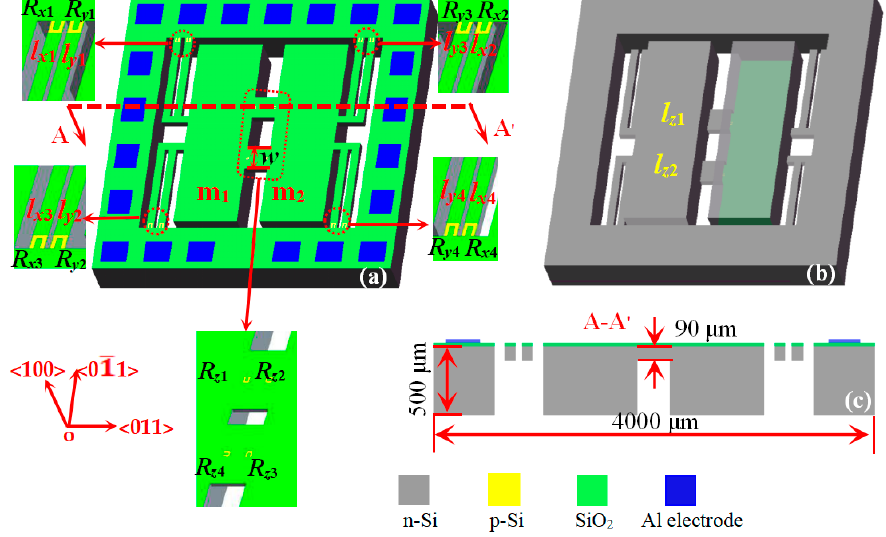
Figure 1. The basic structure of the three-axis accelerometer with double L-shaped beams: ( a ) top view; ( b ) bottom view; and ( c ) cross-section view along